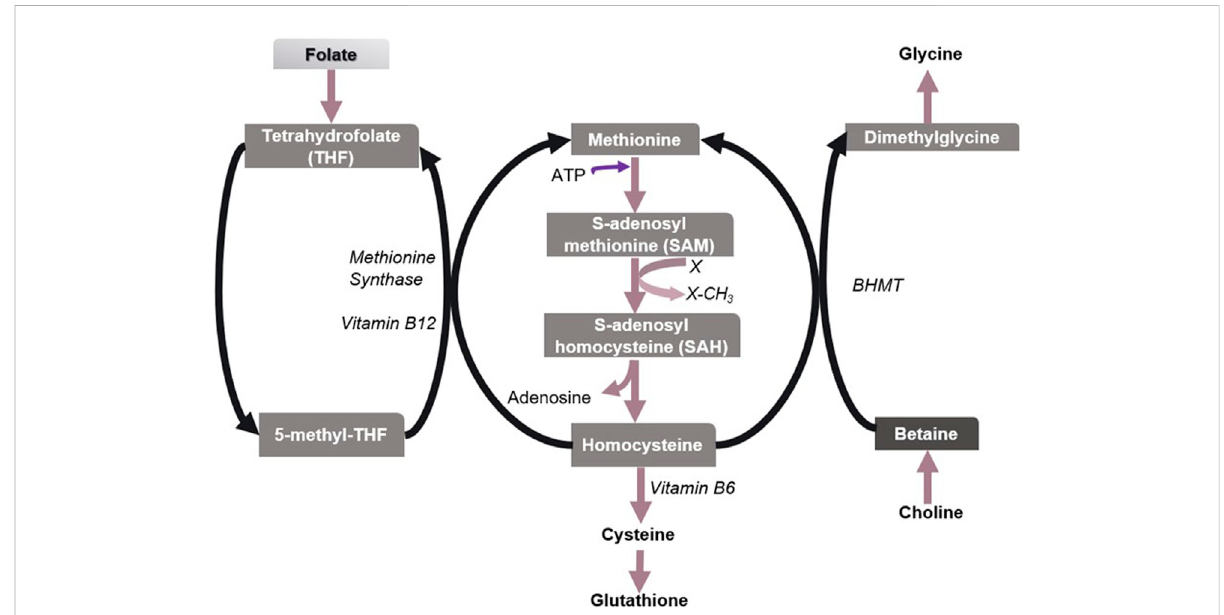
Metabolism of sulfur amino acids in the liver. Methionine/SAM, Folate/5-methyl-THF, and choline/betaine are important biological methyl group donors in methyl group transfer reactions. X denotes a methyl group acceptor. Betaine has been found to play a vital role in the methionine- homocysteine cycle and hence in maintaining the SAM/SAH ratio in the liver, especially when folate is insuf fi cient.